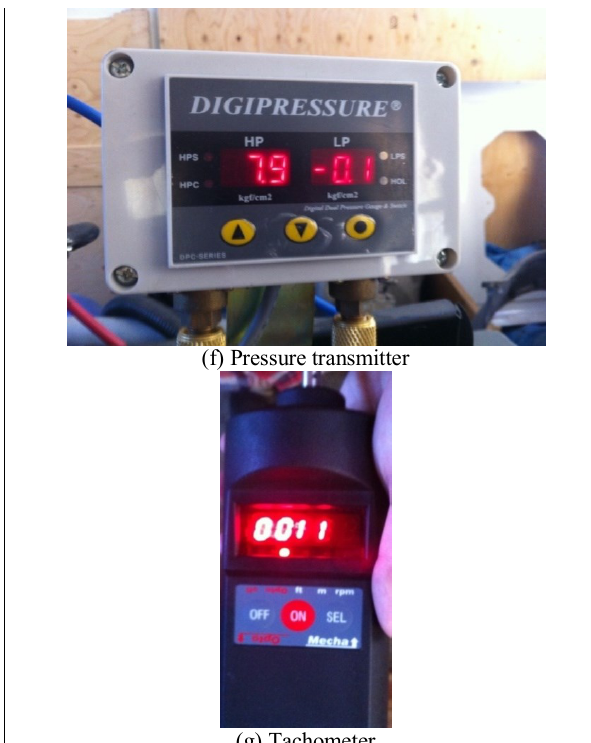
Fig. 5. Idea and real P-h and T-s charts